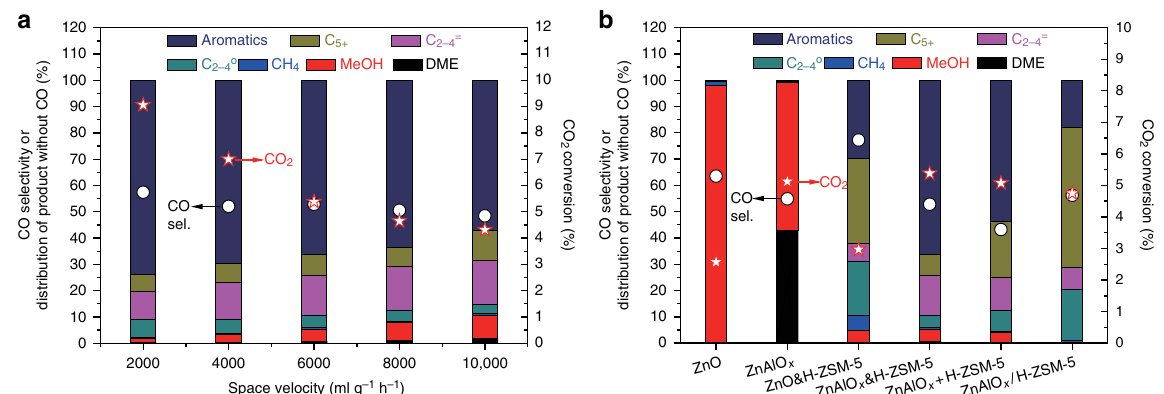
Fig. 1 Catalytic performance for CO 2 hydrogenation. a The effect of space velocity over ZnAlO x &H-ZSM-5. Reaction conditions: 593 K, 3.0 MPa, H 2 /CO 2 / Ar = 3/1/0.2. b Comparisons of the CO 2 conversion and product selectivity over various catalysts. Reaction conditions: Space velocity = 12,000 (for ZnO and ZnAlO x ) or 6000 (for composite catalysts) ml g − 1 h − 1 , 3.0 MPa, 593 K, H 2 /CO 2 /Ar = 3/1/0.2. Note that the C 5 + excludes aromatics. C 2-4 = and C 2-4 o refer to C 2 – C 4 ole fi ns and paraf fi ns, respectively; ZnAlO x &H-ZSM-5 prepared by grinding; ZnAlO x + H-ZSM-5 prepared by granules mixing; ZnAlO x